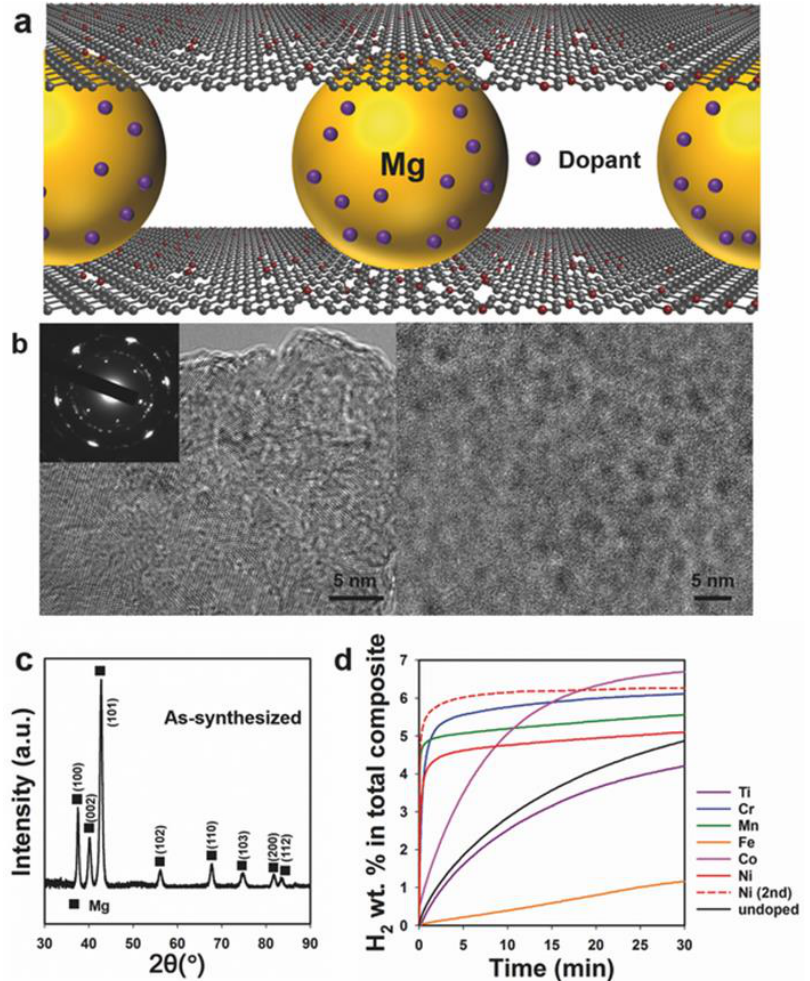
Figure 7. ( a ) Illustration describing Mg nanocrystals encapsulated by reduced graphene oxide layers with transition metal dopants (transition metal doped rGO–Mg); the cartoon is based upon microscopy data and not intended to be an atomistic model. ( b ) Transmission electron microscope (TEM) images of the Ni-doped rGO–Mg. The diffraction pattern from TEM images is shown in the inset which indicate the crystalline lattice of Mg (010), (002), (100), and graphene (100). ( c ) X-ray diffraction pattern of as-synthesized transition metal doped rGO–Mg composite; well-defined Mg crystalline structures were observed for all transition metal doped rGO–Mg composites regardless of the specific dopant, and a representative pattern is shown for Ni-doped rGO–Mg. ( d ) Hydrogen absorption behaviors of a series of 3d transition metal doped rGO–Mg composites at 15 bar of H 2 and 200 ◦ C in comparison with undoped rGO–Mg; red solid and dashed line represent the absorption of the first and the second hydrogen sorption cycles for Ni-doped rGO–Mg, respectively. Adapted with permission from